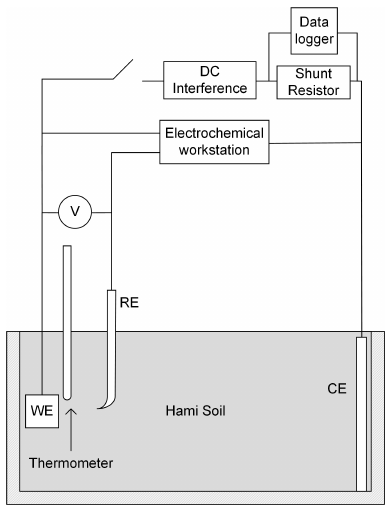
Figure 2. Schematic of the high voltage direct current (HVDC) interference and test